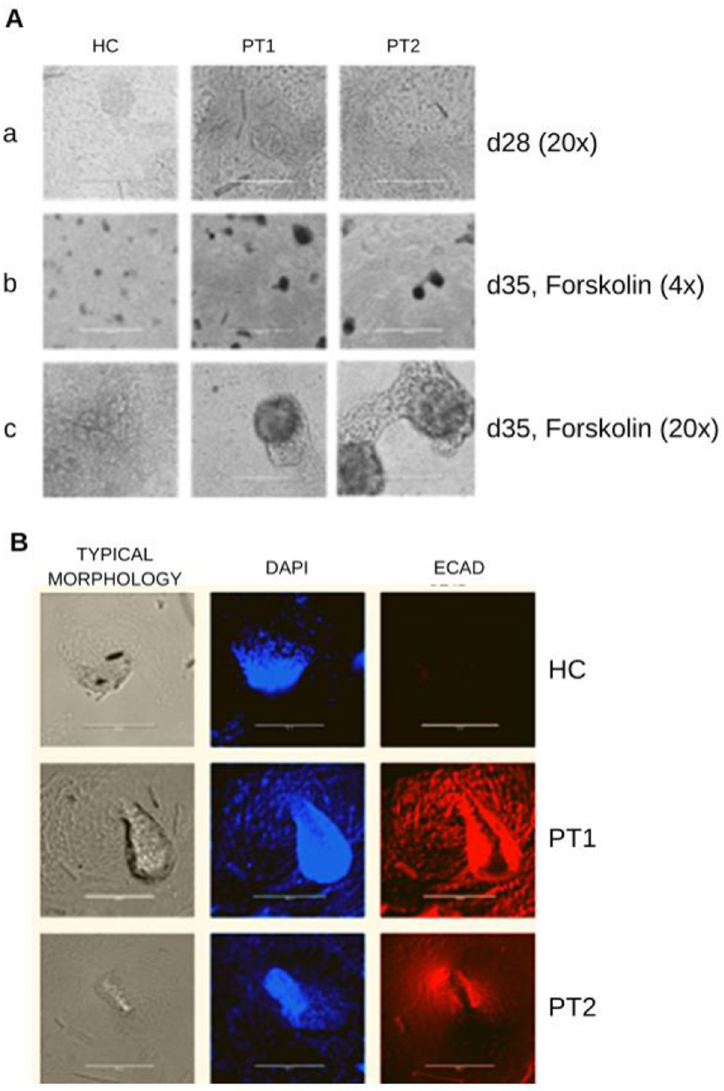
Fig 6. Organoid and cyst formation. Representative images of organoids after cyst induction with forskolin for HC, PT1 and PT2. Typical morphology of organoids on day 28 without forskolin induction (A-a). Images of several organoids on day 35 in culture upon forskolin induction 4X (A-b). Typical morphology on day 35 upon forskolin induction showing cyst formation, 20X (A-c). B Representative immunostaining of ECAD markers showing the typical morphology of kidney organoids. Cell nuclei were stained with DAPI (second columns). ECAD was not detected in the HC (R&D Systems 1:500), but it was detected in PT1 and PT2. A-B: 20X. (scale bar 200 μ m).